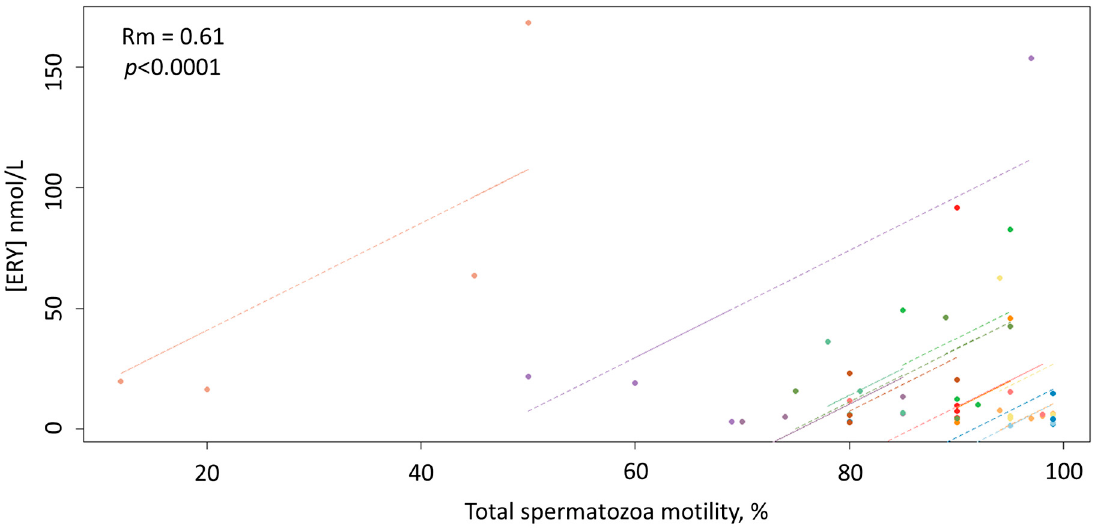
Figure 2. Scatterplots of the linear relationship between the concentrations of ERY and the total spermatozoa motility.